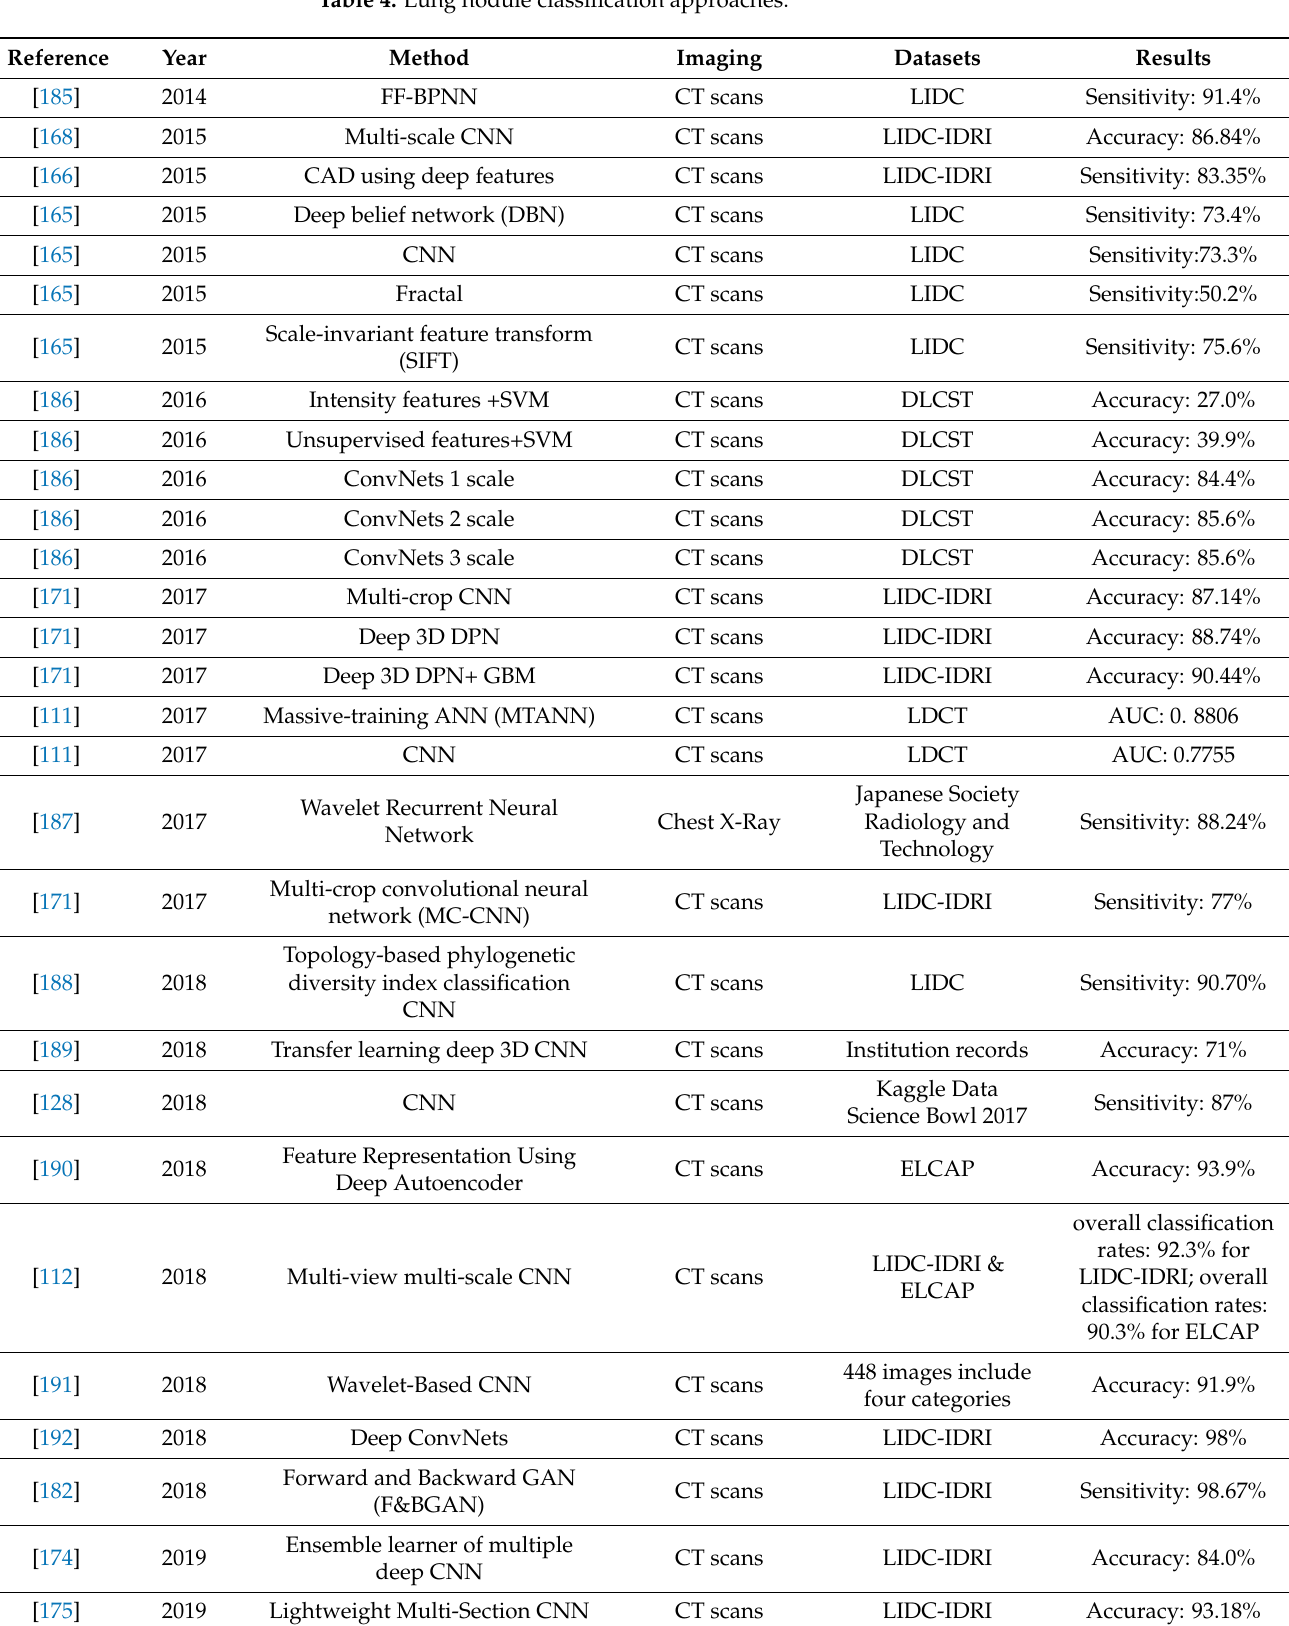
Table 4. Lung nodule classification